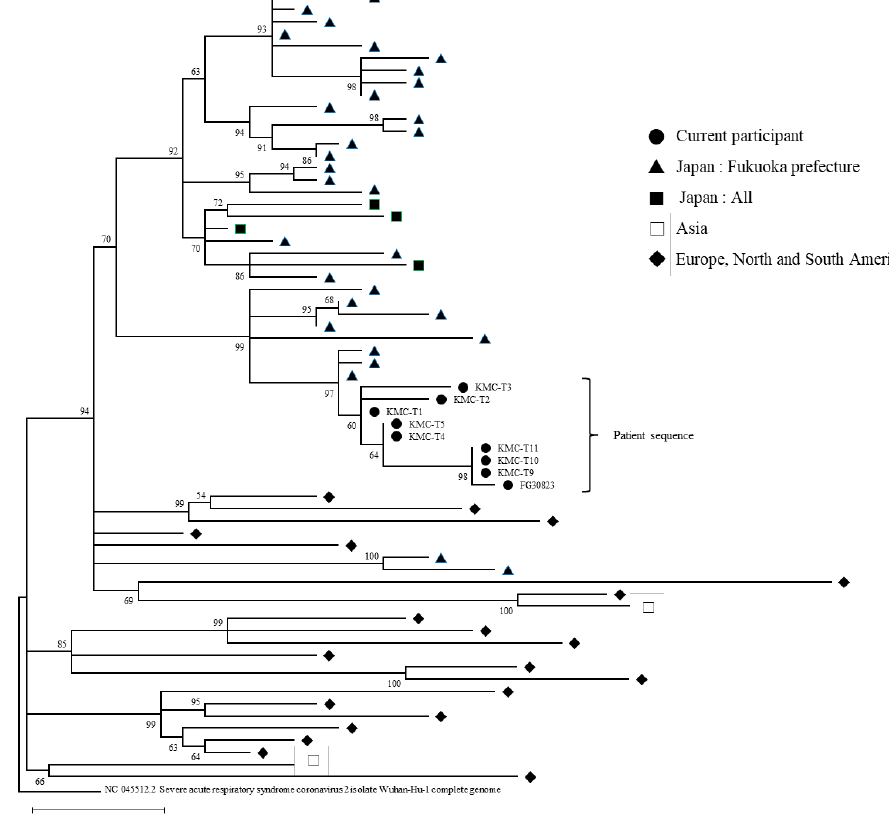
Figure 3. Phylogenetic analysis of SARS-CoV-2 whole-genome virus nucleotide sequences from lon- gitudinally collected nasopharyngeal swab or saliva specimens. Phylogenetic trees were constructed by the maximum likelihood method. Nucleotide sequences of SARS-CoV-2 were obtained from nasopharyngeal swabs or saliva that were collected from the patient at nine time points (● ; T1, T2, T3, T4, T5, T9, T10, T11, and T12). Sequences were collected from samples from Fukuoka Prefecture, Japan ( (cid:78) ) and all regions in Japan ( (cid:4) ), Asia and Europe ( (cid:3) ), and North and South America ( (cid:117) ), as reference sequences. The scale represents 0.0002 nucleotide substitutions per